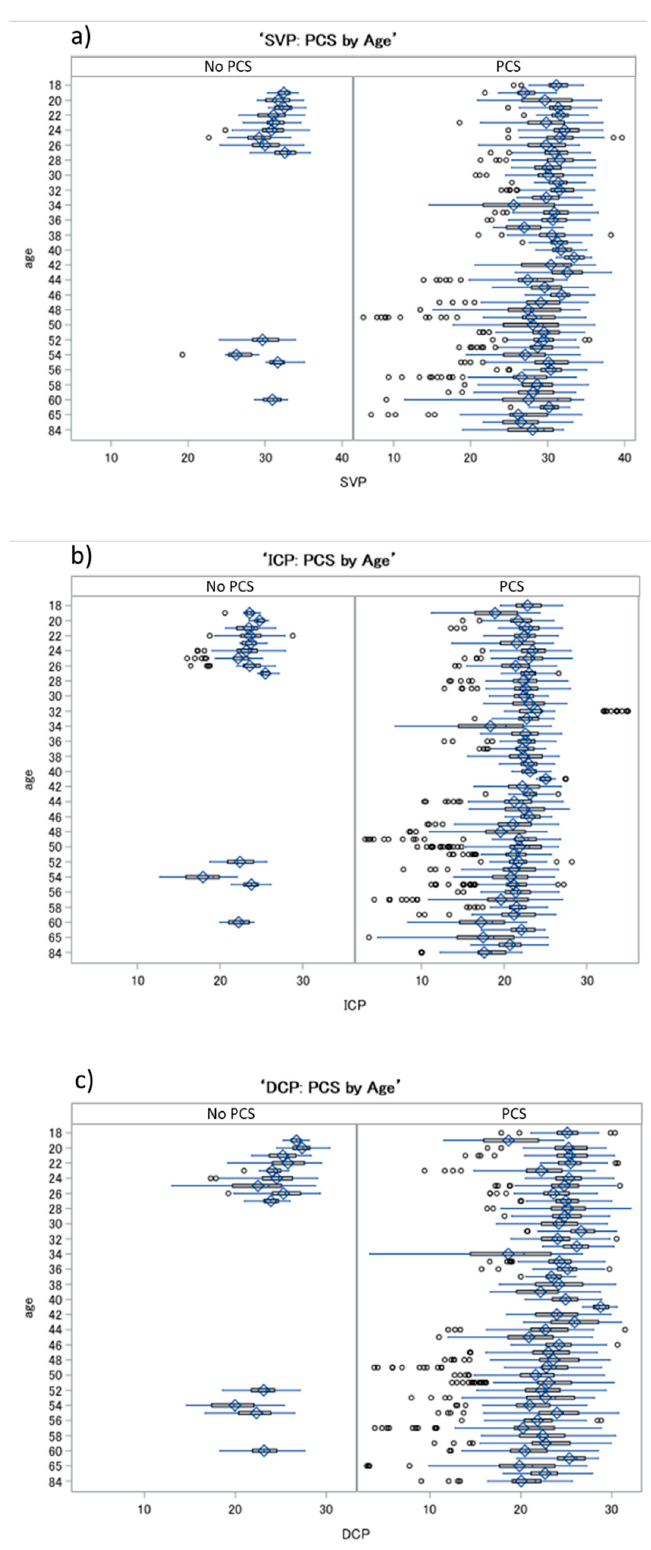
Figure 1. Boxplots of VDs in the SVP ( a ), ICP ( b ) and DCP ( c ) in patients with post-COVID-19 syndrome (PCS) and controls, considering the cofactor of age: a decrease in VD in all retinal layers was observed with increasing age in PCS patients and controls. SVP—superficial vascular plexus, ICP—intermediate capillary plexus, DCP—deep capillary plexus.